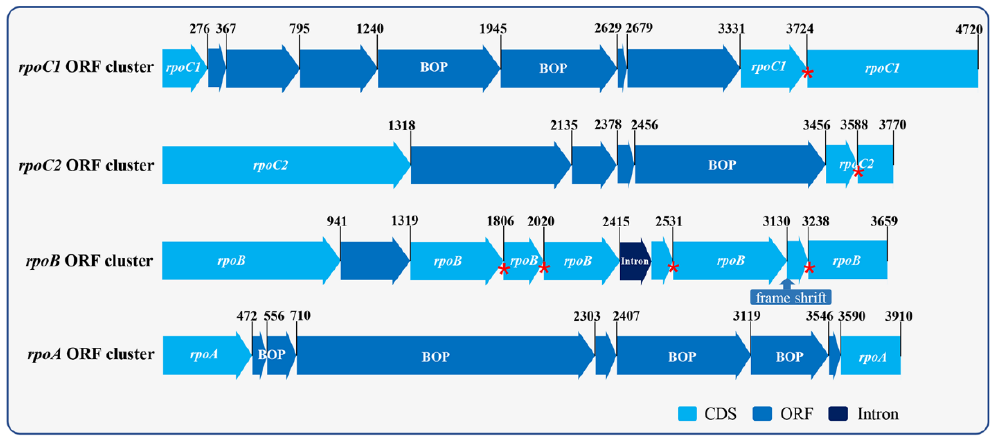
Figure 8. The fragmentation of rpo gene cluster. The red asterisk represents a detected in-frame stop codon; the shift mutation was labelled in a blue arrow. The BOP, EOP and POP represent ORF may have a bacteria, eukaryotic nucleus, and chloroplast origin respectively. ORF without BOP, EOP or POP label means no blast hit.